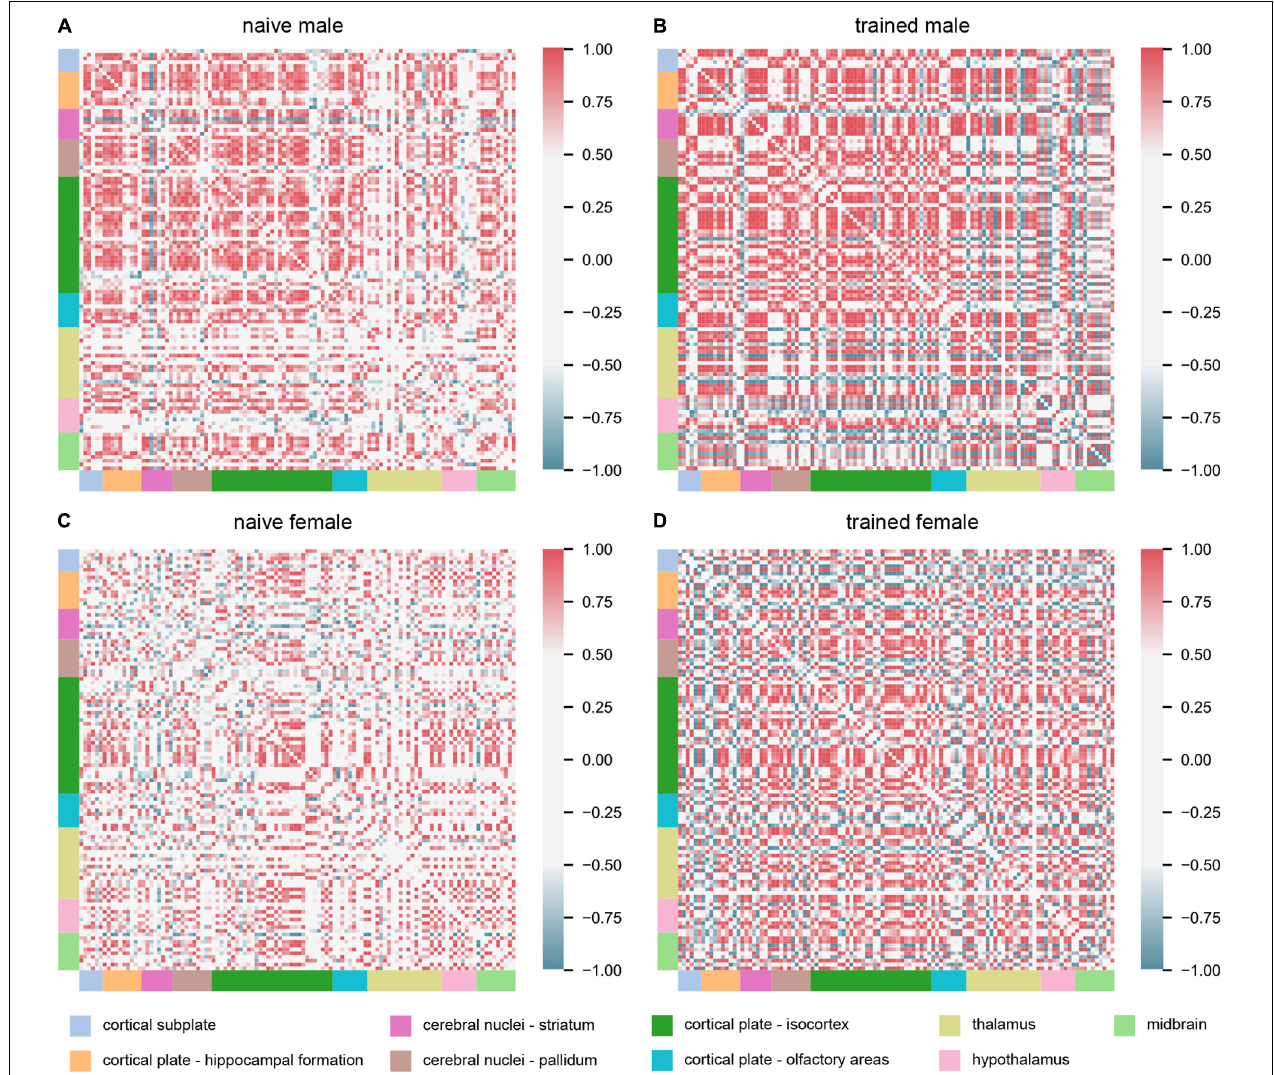
FIGURE 3 | Cued threat conditioning engages broadly distributed, sex-specific functional networks. Matrices showing interregional correlations of c-fos expression across experimental groups: (A) naïve male ( n = 4), (B) trained male ( n = 3), (C) naïve female ( n = 4), and (D) trained female ( n = 3). The axes correspond to 112 brain regions organized into major divisions, represented by colored bars. For an ordered list of brain regions represented in the matrices, see Supplementary Table 3 . Matrix colors represent the strength of the correlation (Pearson’s r ; scale,